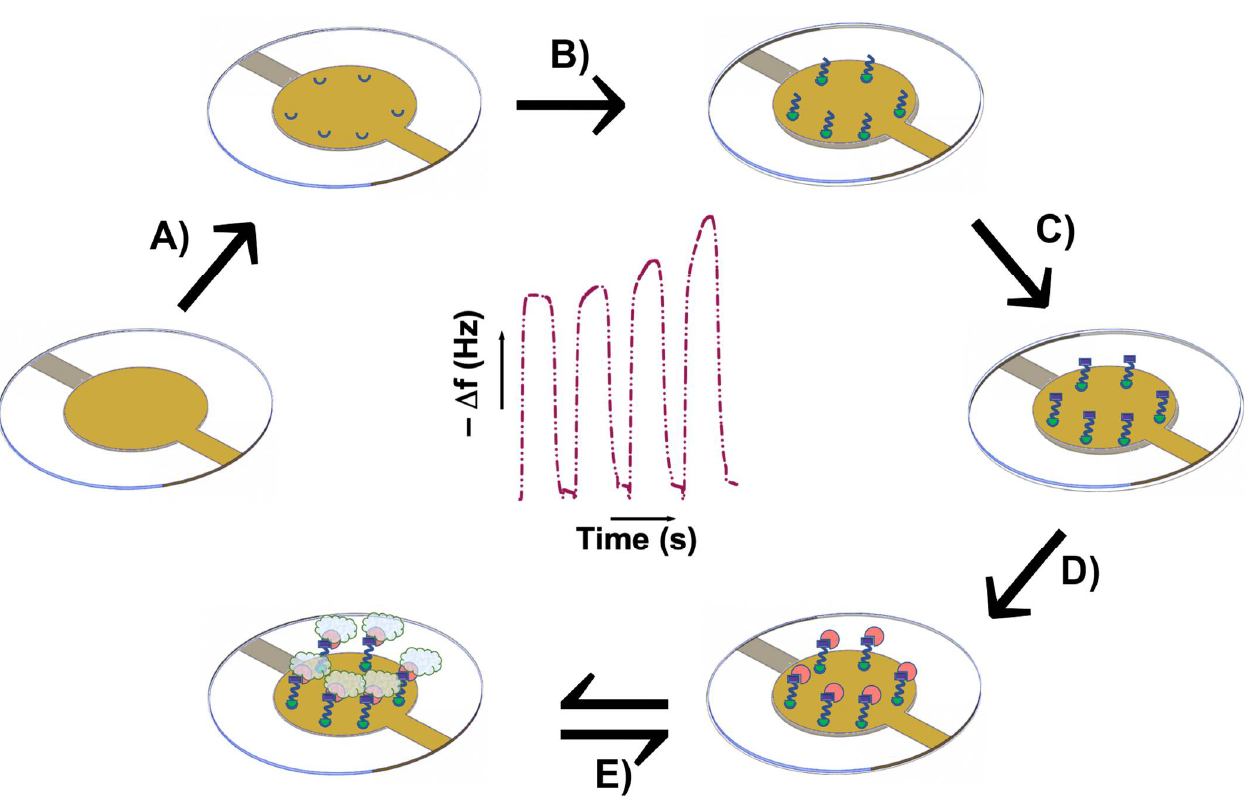
Figure 6. Schematic representation of the immobilization of oxytocin on QCM chips for the detection of O-NPs; ( A ) LNB carboxyl surface activation by EDC/sulfo-NHS, ( B ) ACA immobilization, ( C ) ACA surface activation by EDC/sulfo-NHS, ( D ) oxytocin immobilization, ( E ) O-NPs